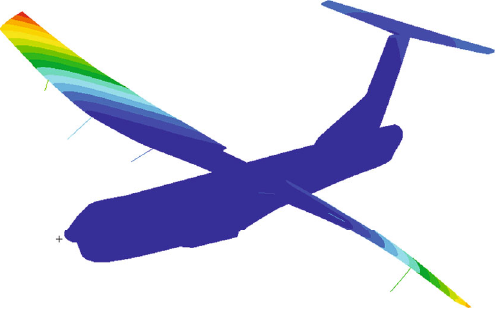
Figure 5: Wet mode shape of 1st wing antisymmetric bending.